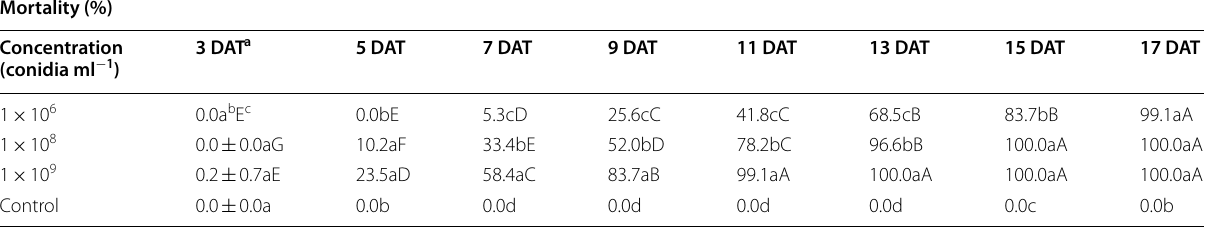
a DAT: Days after treatment b Means in a column followed by the same letter are not statistical significantly different (ANOVA P < 0.05, Tukey’s test) c Means in a line followed by the same capital letter are not statistical significantly different (ANOVA P < 0.05, Tukey’s